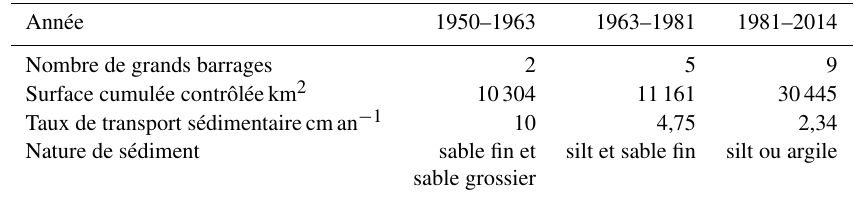
Tableau 3. Evolution des sédiments transportés dans la basse vallée de Medjerda depuis